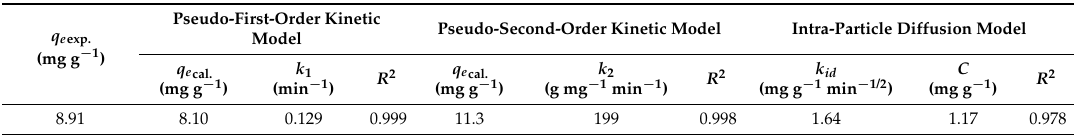
Table 2. Parameters obtained for different kinetic models of the adsorption of Sb (III) on ox-xGnP, at T = 293